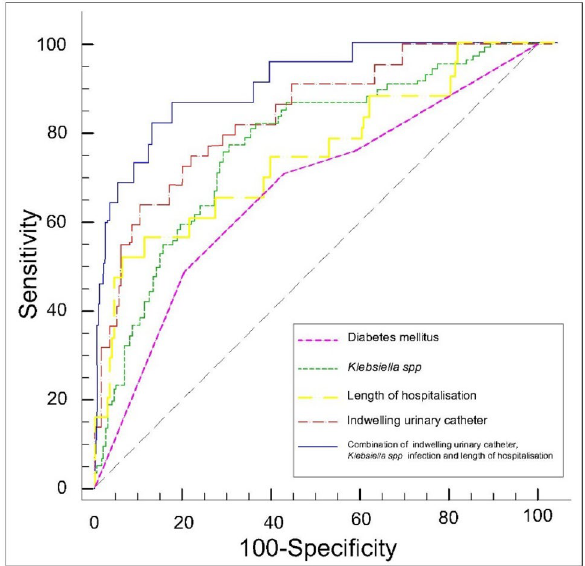
Figure 1. Receiver operating curve (ROC) for urosepsis risk score prediction in CKD patients with